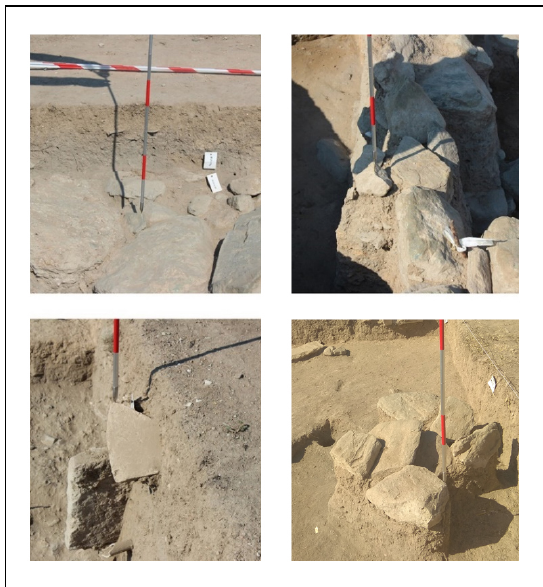
Figure 3 . Selected Ground Control Points measured during the topographic survey campaign.